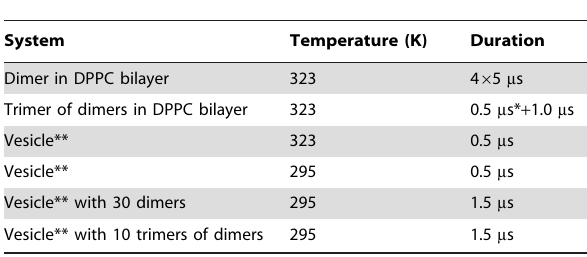
Table 1. Summary of simulations.